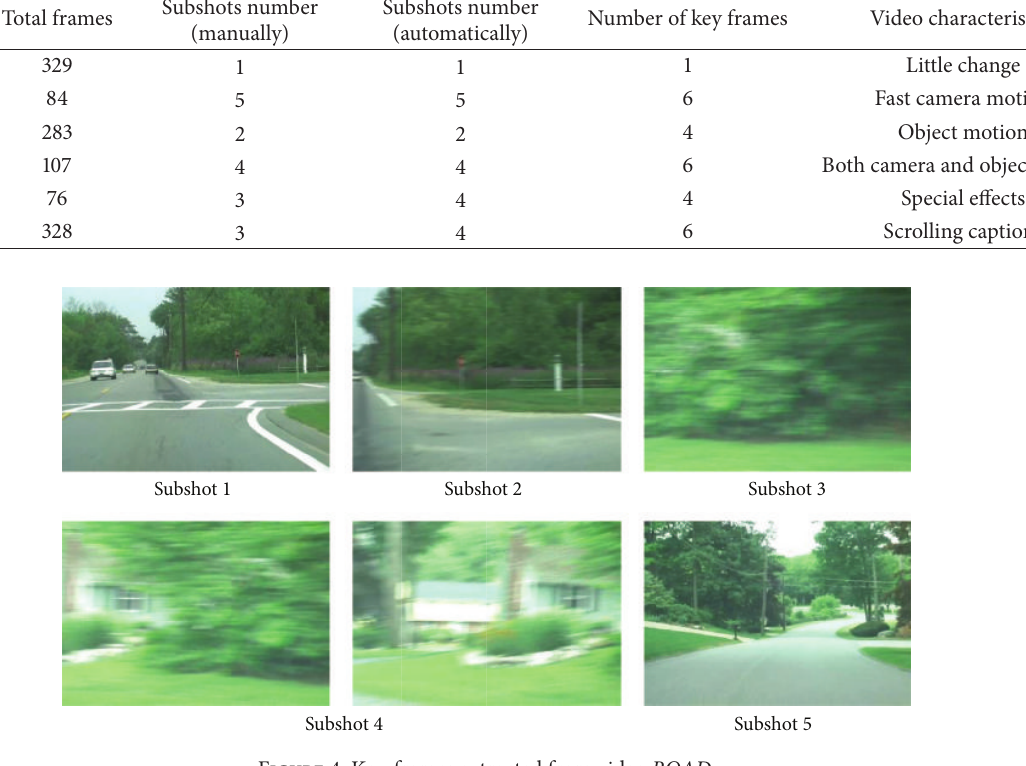
Figure 4: Key-frames extracted from video ROAD .